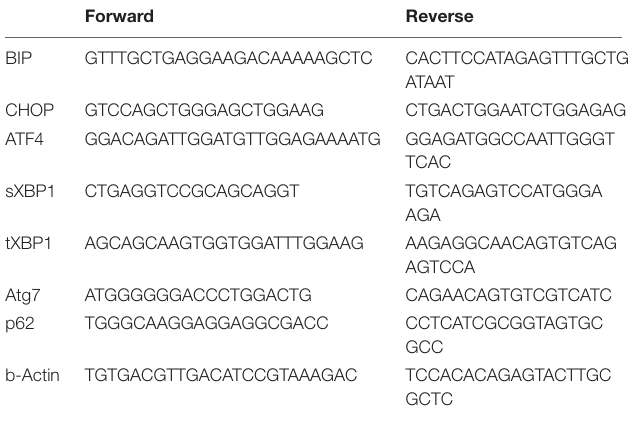
TABLE 1 | Forward and reverse primers used for